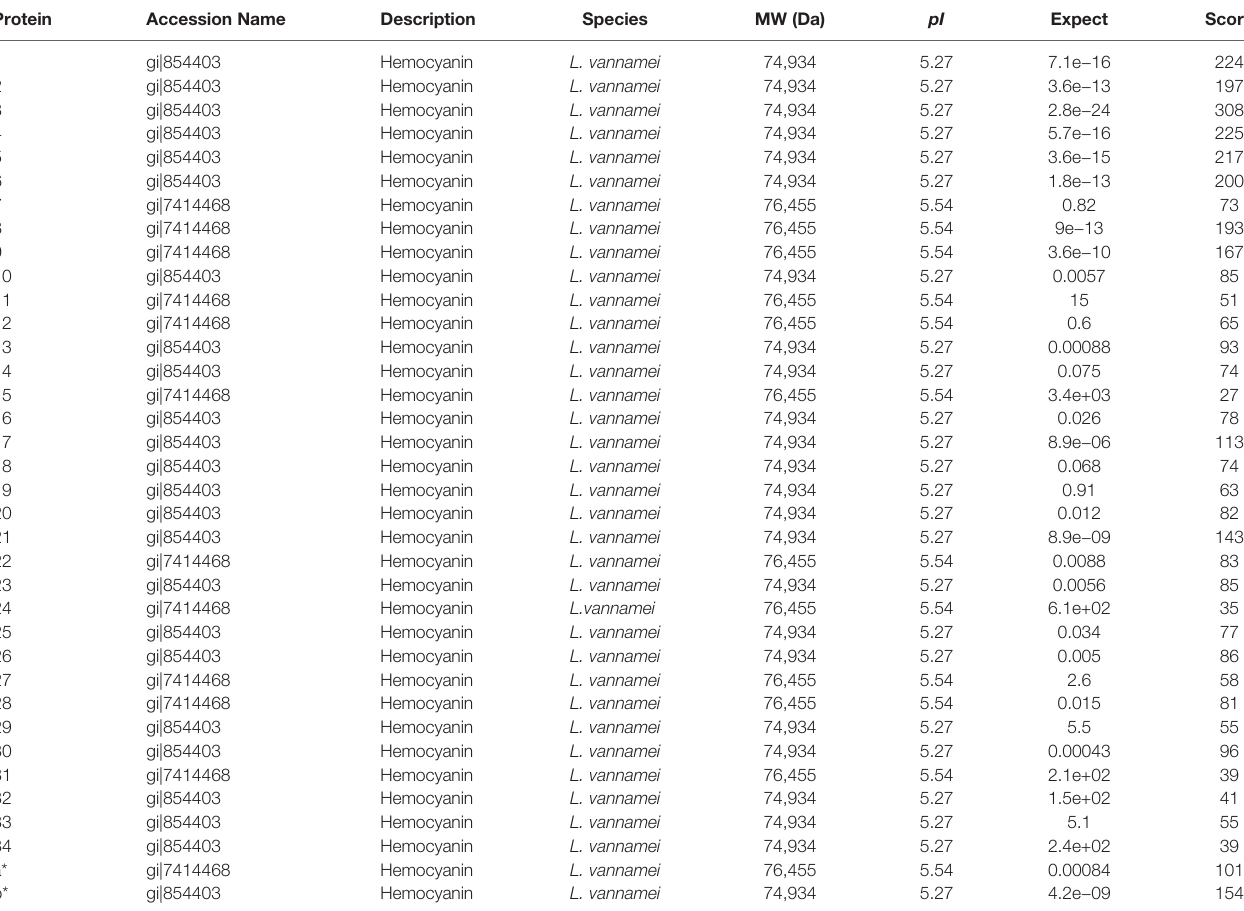
*Protein band identi fi cation in Figure 3A